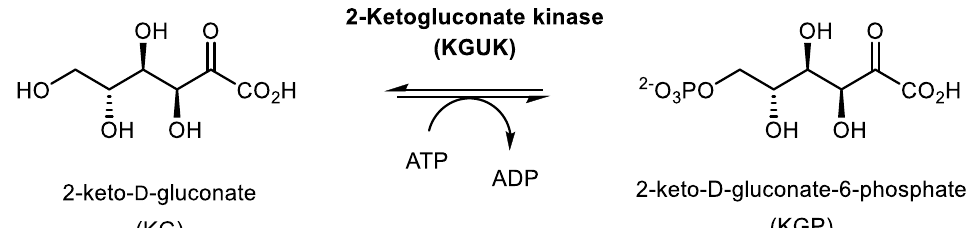
Figure 1. Reaction catalyzed by 2-ketogluconate kinase (KGUK).